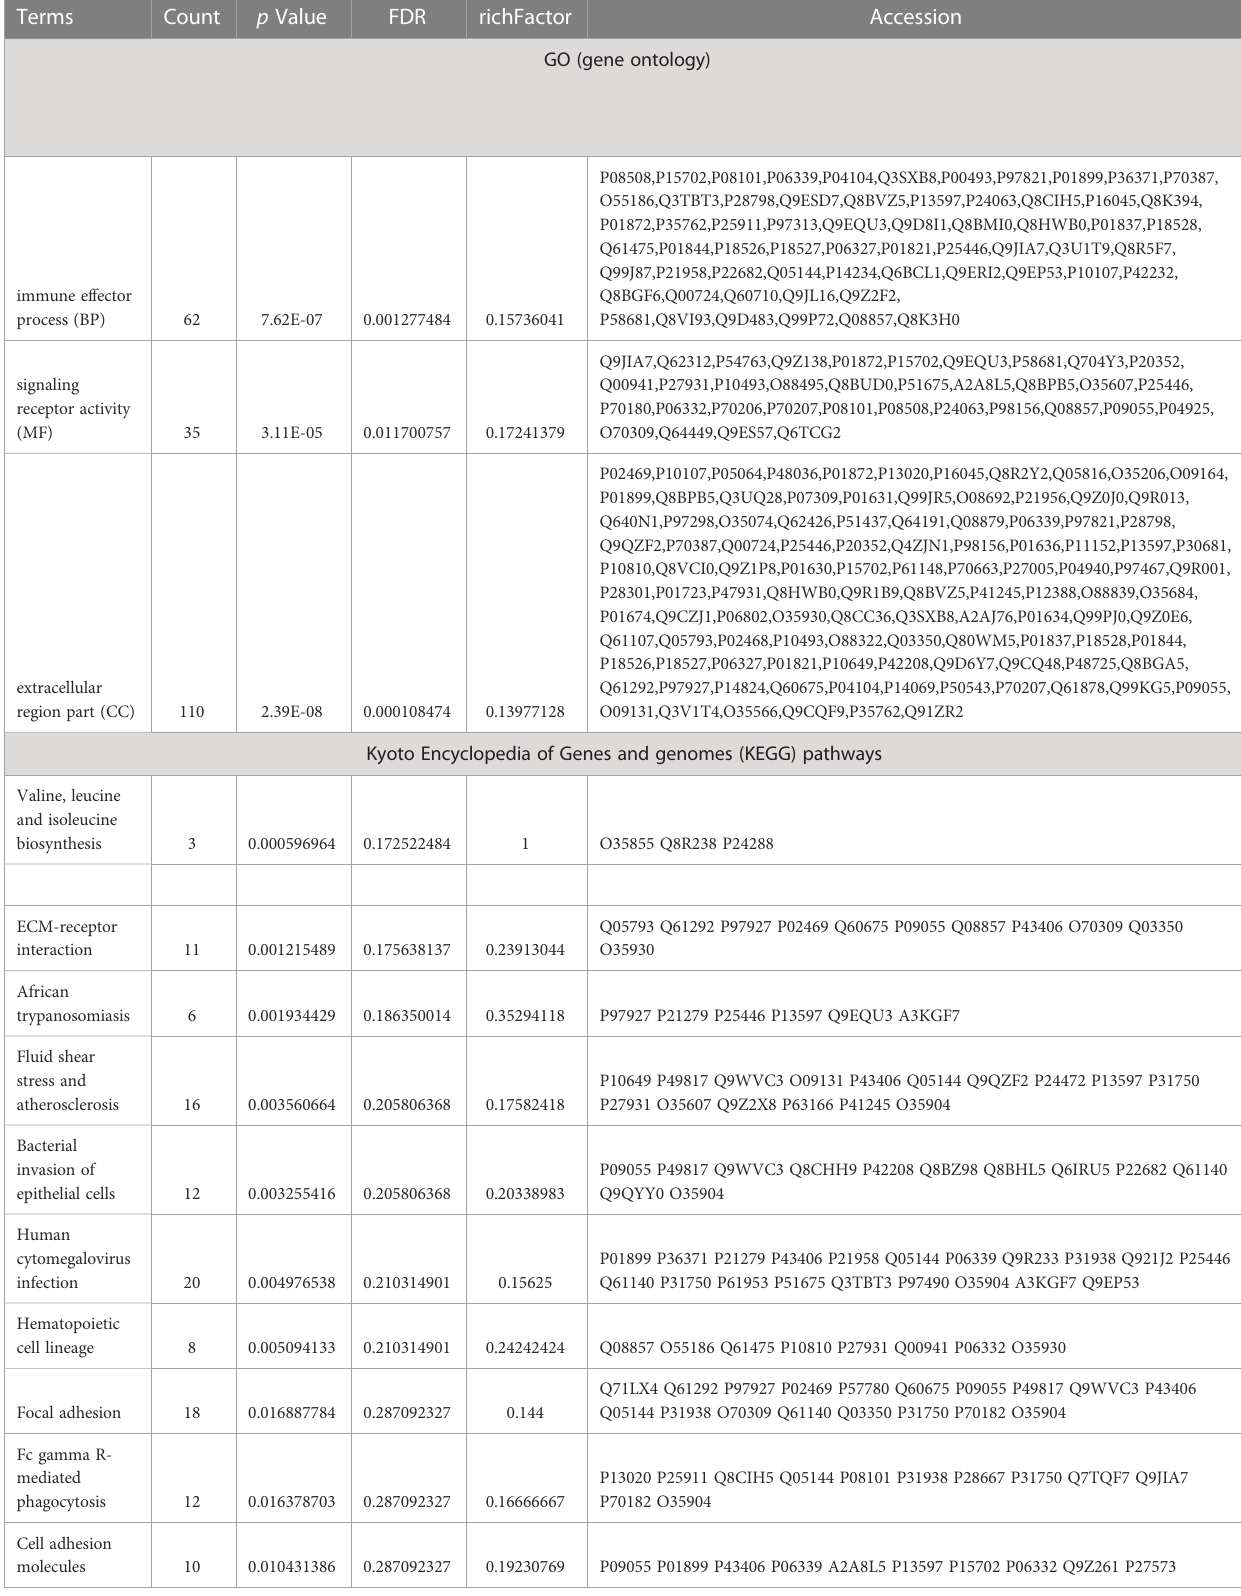
TABLE 3 Distribution of proteins and signaling pathways between Sema and HFD groups, based on GO and KEGG